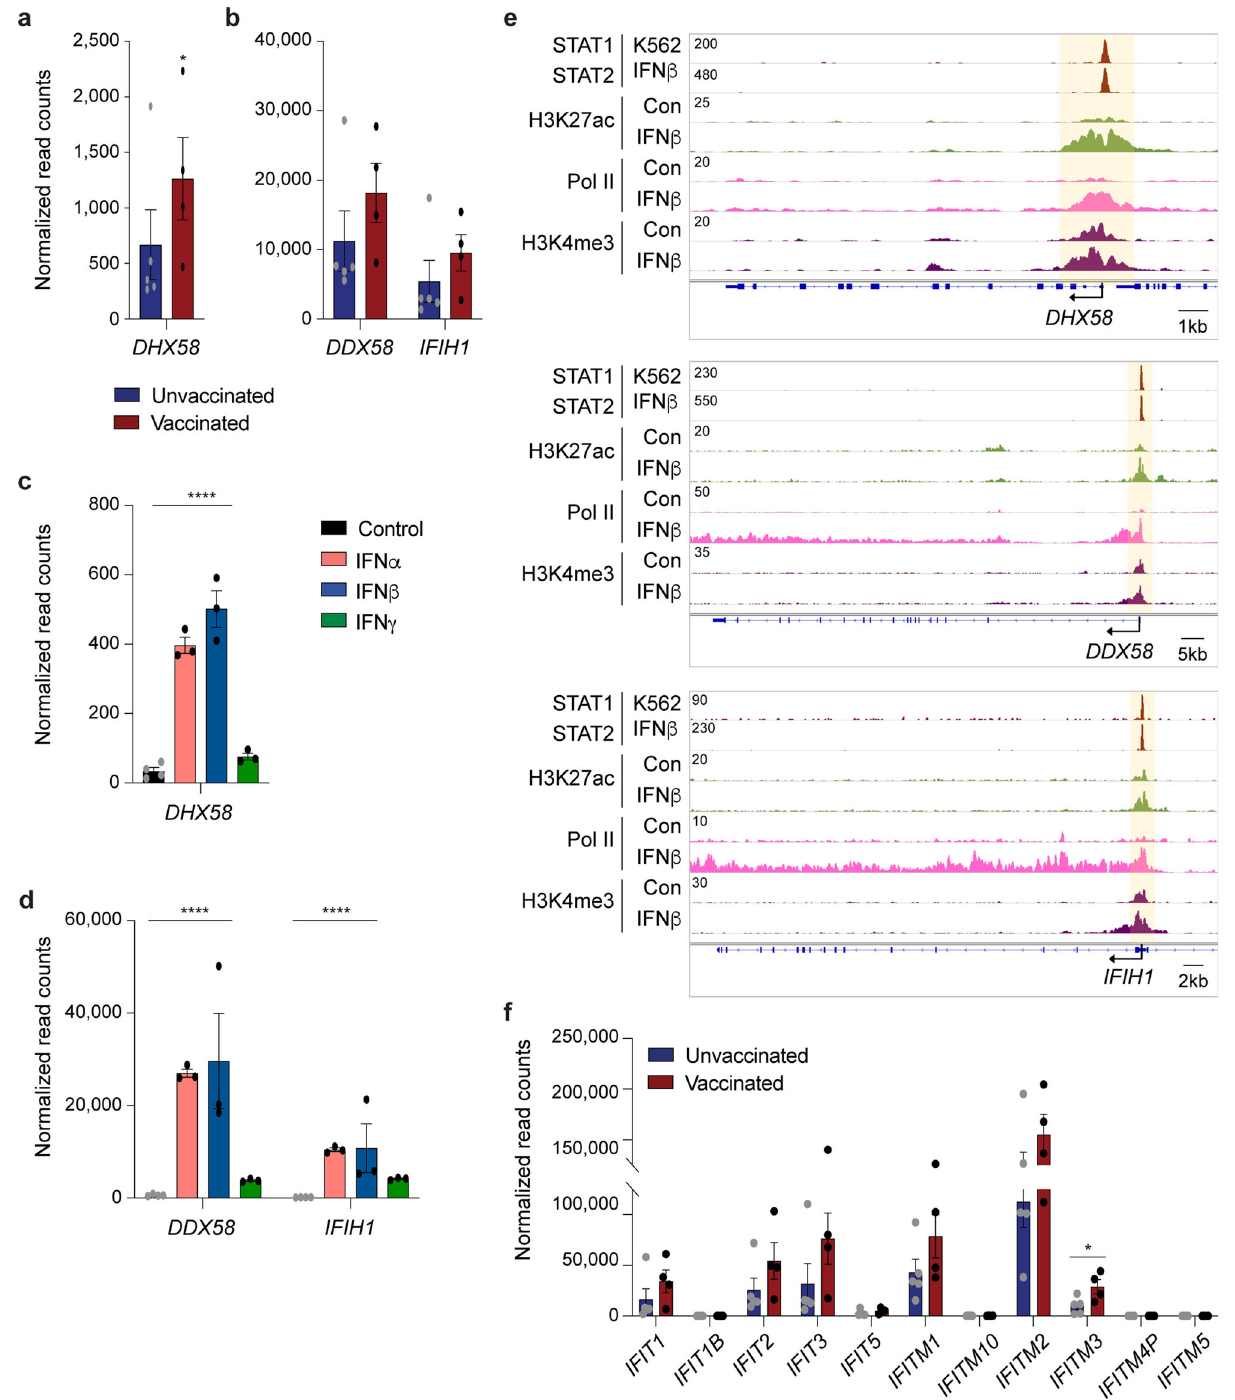
Fig. 3 Regulation of innate immune response genes. a , b Relative normalized expression of the RIG-I-like receptors family members DHX58 ( a ), DDX58 and IFIH1 ( b ) in vaccinated and unvaccinated patients. A two-tailed unpaired t -test with Welch ’ s correction was used to evaluate the statistical signi fi cance between the two groups. * p < 0.05 c , d DHX58 ( c ), DDX58 and IFIH1 ( d ) mRNA levels from primary bronchial cells treated with IFNs were measured by RNA-seq 12 . Results are shown as the means ± s.e.m. of independent biological replicates ( n = 3). **** p < 0.00001 e ChIP-seq for STAT transcription factors, the histone marks H3K27ac and H3K4me3, and Pol II was conducted in primary bronchial cells in the absence and presence of IFN β . f mRNA levels of IFIT gene family members in vaccinated and unvaccinated patients. A two-tailed unpaired t -test with Welch ’ s correction was used to evaluate the statistical signi fi cance between the two